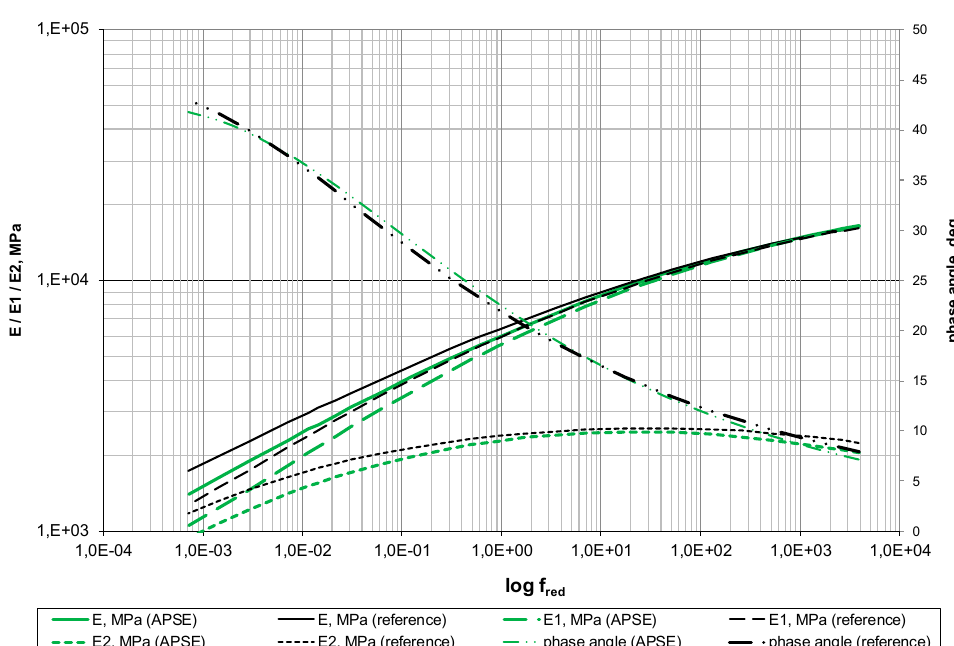
Figure 3. Master curves of the complex modulus and reference modulus of the APSE mixture.